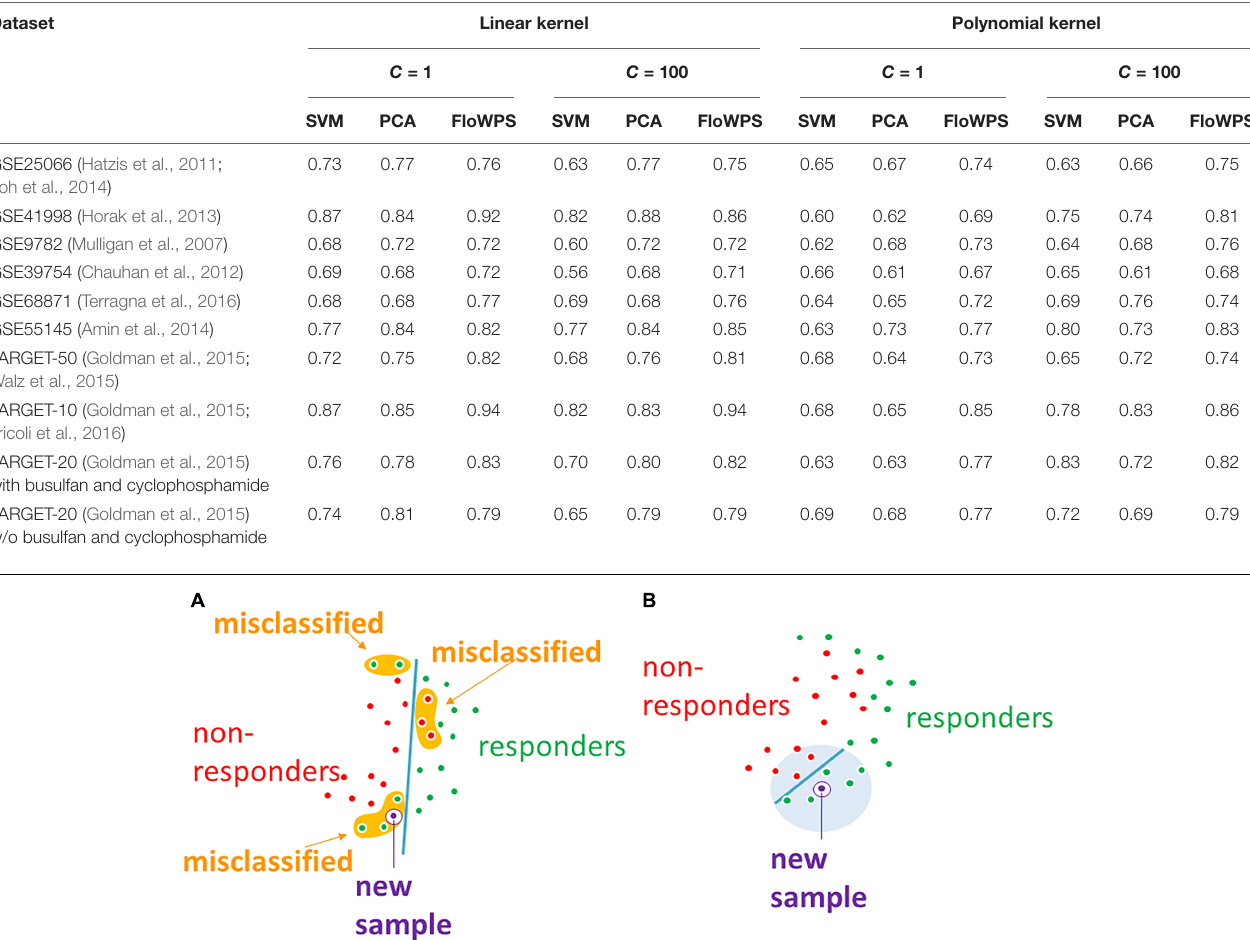
TABLE 3 | AUC of (non)responder classifier for classical SVM without data reduction (SVM), PCA-assisted SVM (PCA) and FloWPS with confidence parameter p = 0.90. Dataset